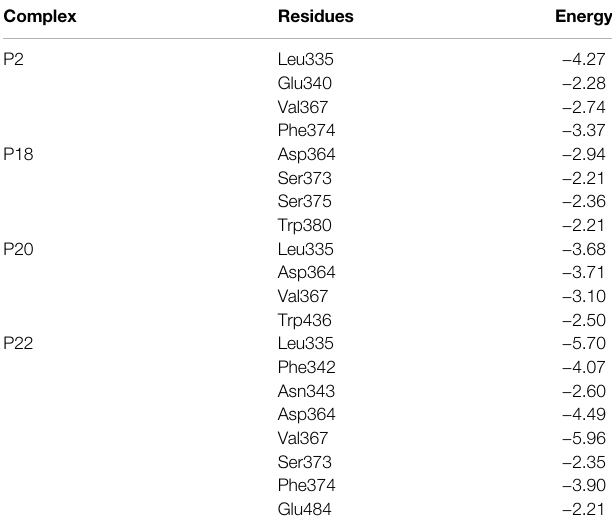
TABLE 3 | The per residue energy contribution from RBD of SARS-CoV-2 where energy contribution was considered < 2 kcal/mol. Complex